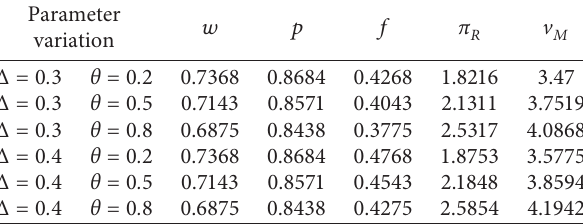
Table 2: Decentralized decision results of CLSC.